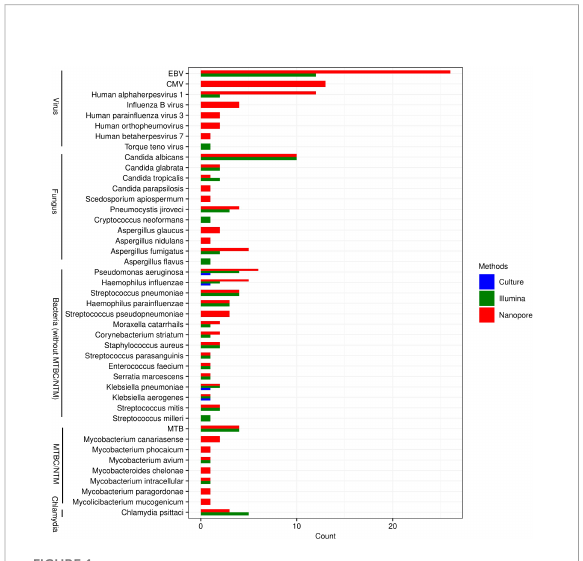
FIGURE 1 Genus distribution of bacterium, fungus, viruses and chlamydiae detected by Illumina, Nanopore and culture. EBV, Epstein-Barr virus; CMV, Human cytomegalovirus; MTB, Mycobacterium tuberculosis; NTM, Non-tuberculous